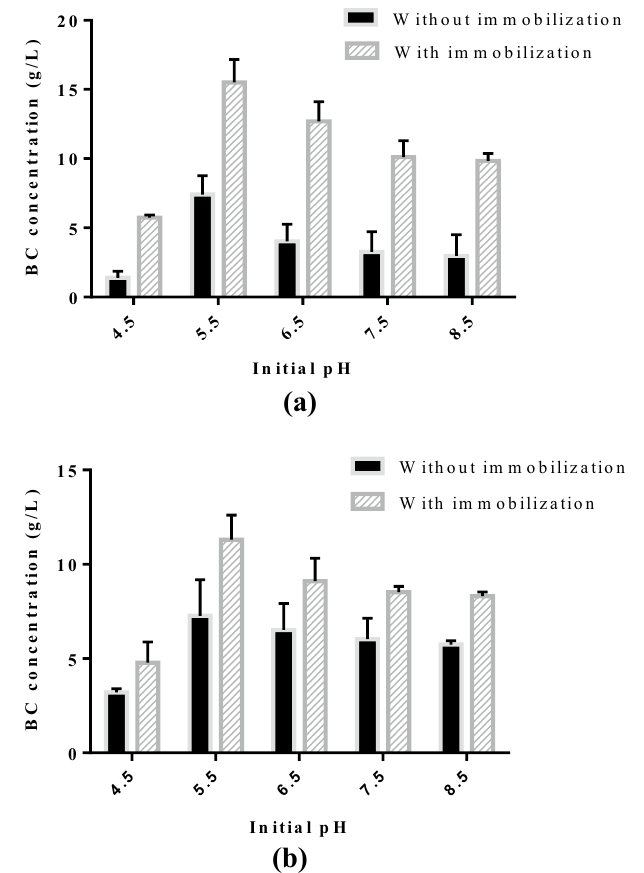
Figure 2. Identification of culturing condition and initial pH in the production of BC ( a ) shaking condition; ( b ) static condition (Fermentation time = 15